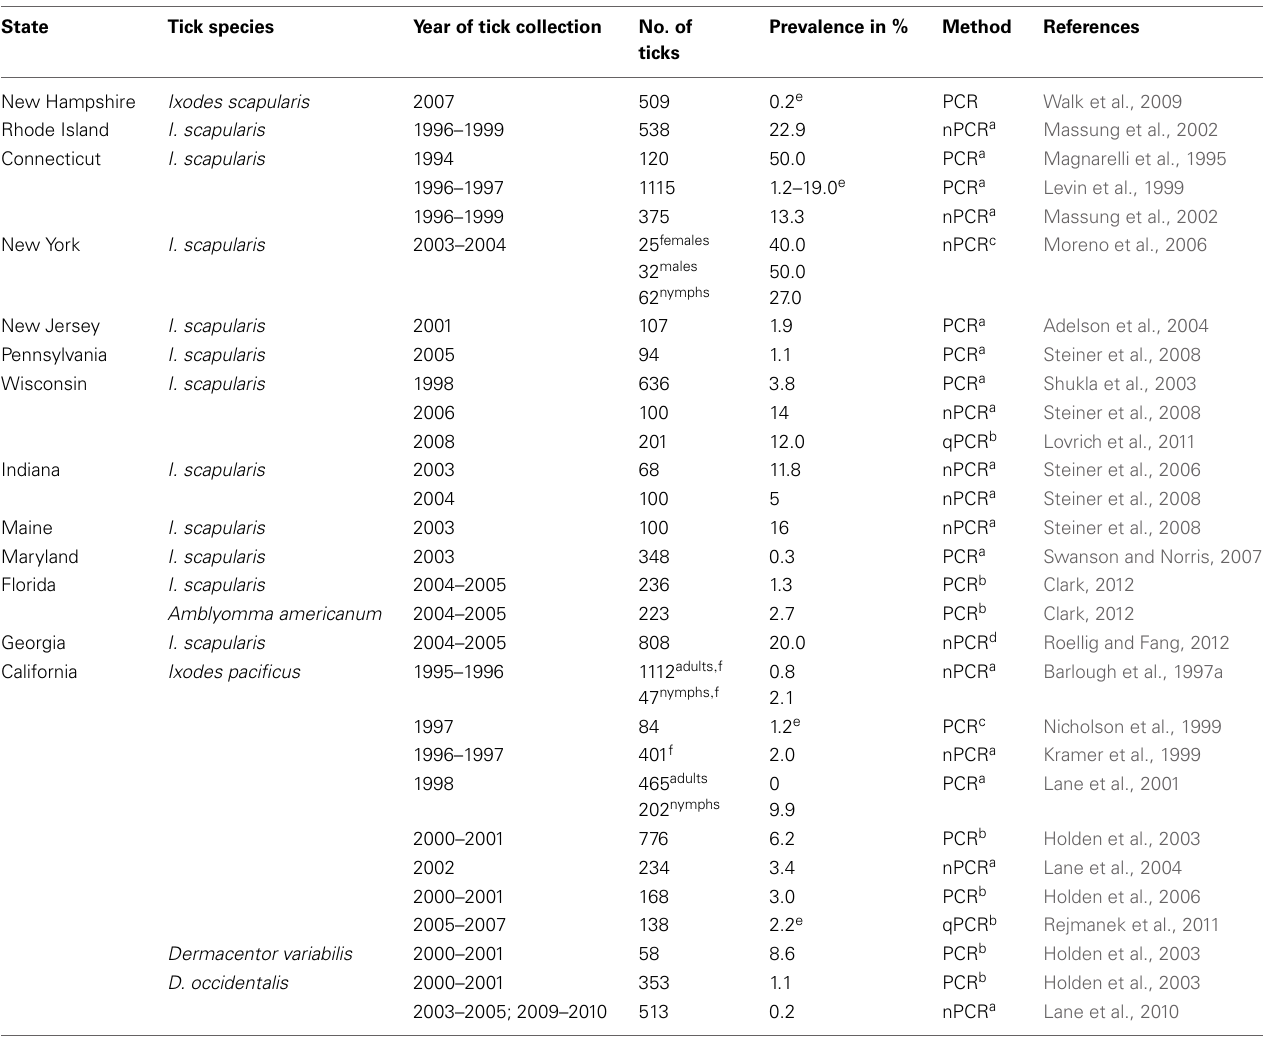
Table 4 | Molecular prevalence studies of Anaplasma phagocytophilum in questing ticks in the